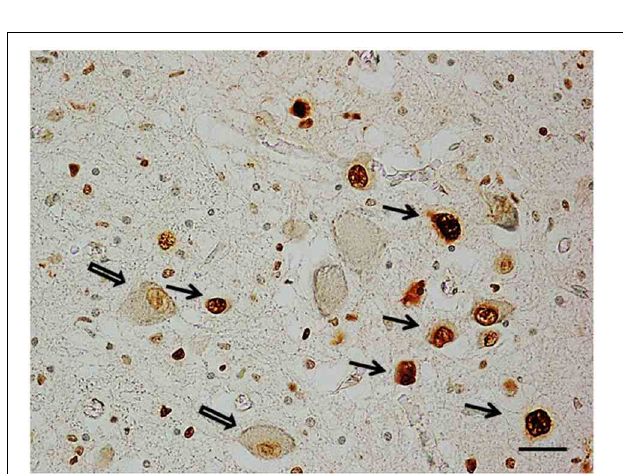
FIGURE 4 | BDNF immunopositivity of several neurons of the Kölliker-Fuse nucleus in a fetus of the control group (34 gestational weeks). BDNF immunostaining. Scale bar = 10 µ m.